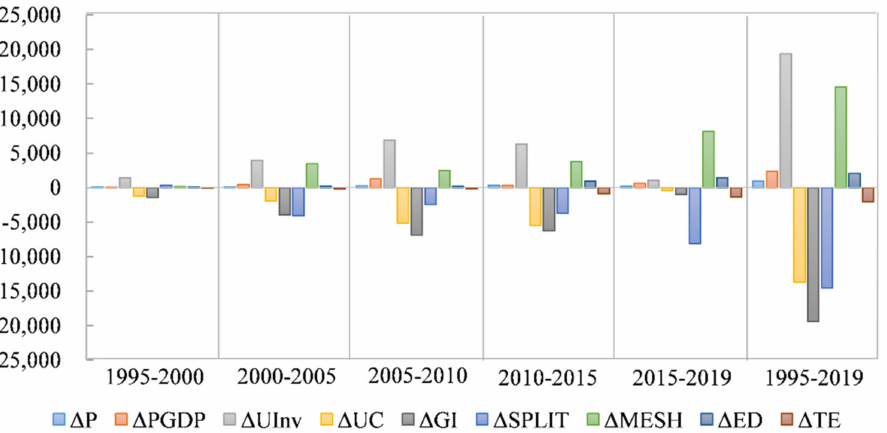
Figure 4. Factorization of four stages; the number is in percentage indicating the growth rate of each component. Table 2. The contribution of each factor to the change of CEs in five periods.